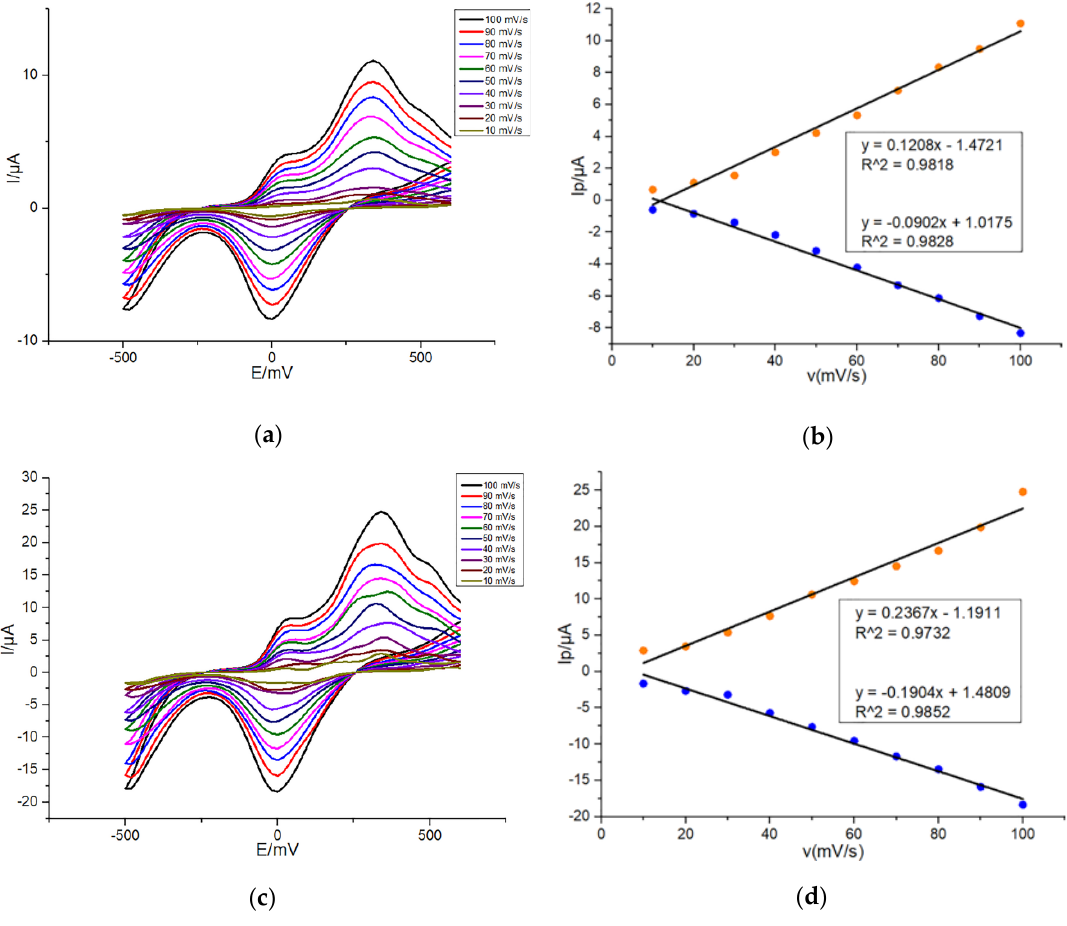
Figure 5. CVs of 10 μM DA, 10 μM AA and 10 μM UA in 0.1-M PBS (pH: 7.4, 0.1-M KCl) at G/SPE ( a ) and PEDOT:PSS/CS–G/SPE ( c ) with a scan rate from 10 to 100 mV/s in 10 mV/s steps; ( b,d ) plots of peak currents of DA oxidation and reduction versus scan rates. Detection parameters: potential range from −500 to +600 mV.